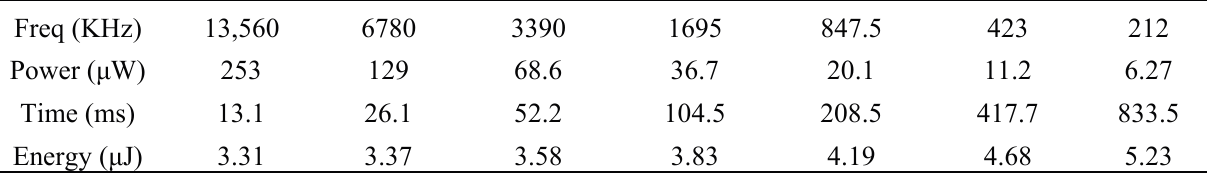
Table 2. Power, time and energy consumptions under different work